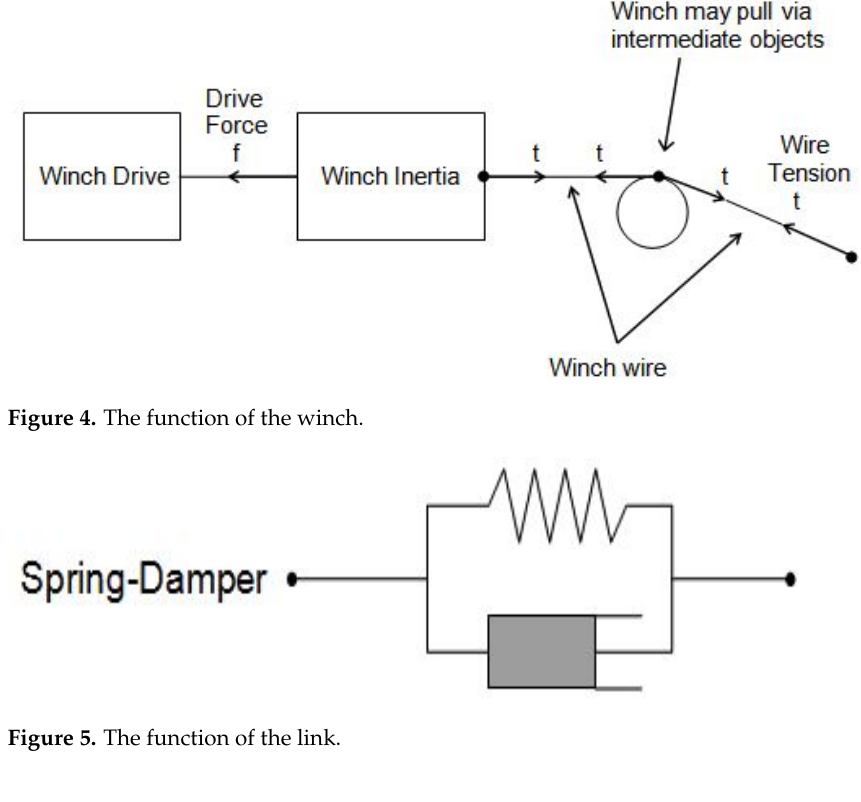
Figure 6. The schematic model of full-circle swing hoisting operation. 3.3. Validation Two cases were studied to validate the correctness of OrcaFlex. The first case is the comparison with the finite element software Flexcom [33]. Flexcom and OrcaFlex were used to establish the analysis model for a 12-inch diameter steel catenary riser (SCR) con- nected to a semi-submersible platform under a water depth of 1800 m. This typical rigid catenary design is used in Gulf of Mexico or West African conditions. The typical limit- and wave-induced fatigue analysis of the model under regular and irregular sea condi- tions was carried out. The selected sea state is representative of typical deep-water Gulf of Mexico sea con- ditions [33]. Therefore, the riser wall was relatively thick. In order to ensure the authen- ticity of the simulation and ensure the induced flutter of the riser and the seabed instabil- ity during the model in-place operation, a large normal seabed stiffness was adopted. The length of the SCR was 2765 m, the diameter of the SCR was 0.308 m, the wall thickness of the SCR was 0.027 m. The riser density was 7.85 t/m 3 . The fluid density in the riser was 0.8 t/m 3 . The normal drag coefficient was 0.3. The force coefficient was 1.2. The normal addi- tional mass coefficient was 1. With the exception that the length of the unit section ap- proximately 300 m from the touchdown end was 1 m, the lengths of other unit sections were set as 5 m. Figure 7 shows the comparison results of bending moment and the time history of the effective tension between Flexcom and OrcaFlex. Figure 8 shows the bend- ing moment distribution of different segment lengths along the length direction.